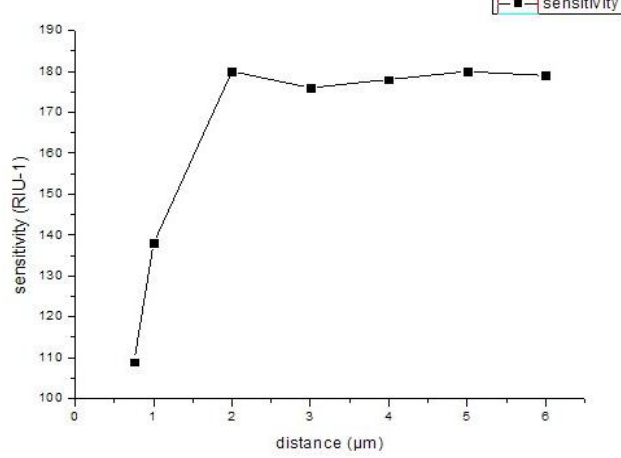
Figure 5. The changes of sensitivity of different relative distances between two silver nanowires in the